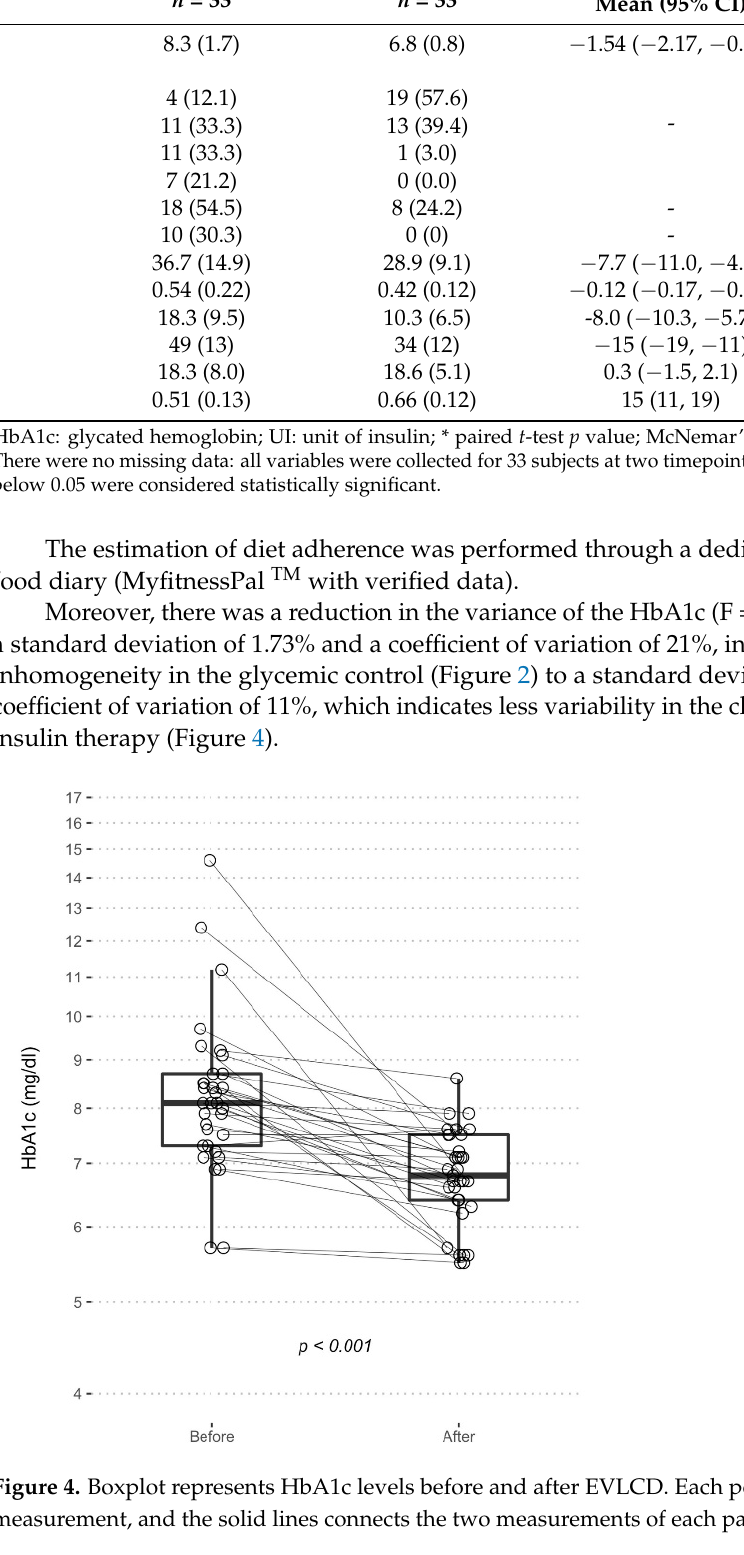
Table 4. Glycometabolic control and therapeutic data of the patients before and after EVLCD. Con- tinuous variables are summarized with mean and standard deviation. Categorical variation are summarized as count (N) or percentage (%).